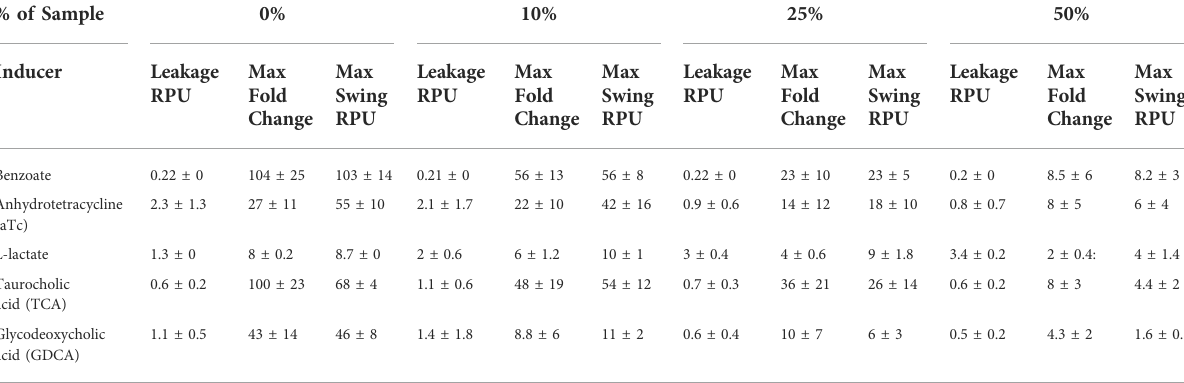
TABLE 1 Functional analysis of biosensors in human feces. % of Sample